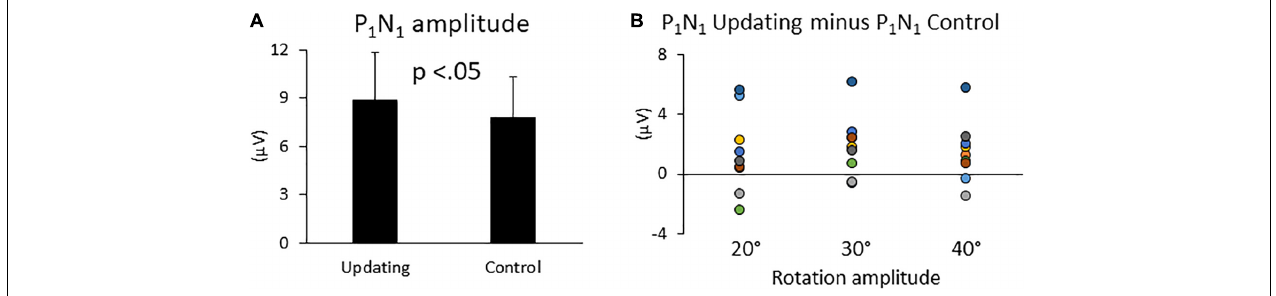
FIGURE 4 | (A) Mean P 1 N 1 amplitudes in the Updating and Control conditions. Error bars represent the error standard of the means. (B) Difference between the P